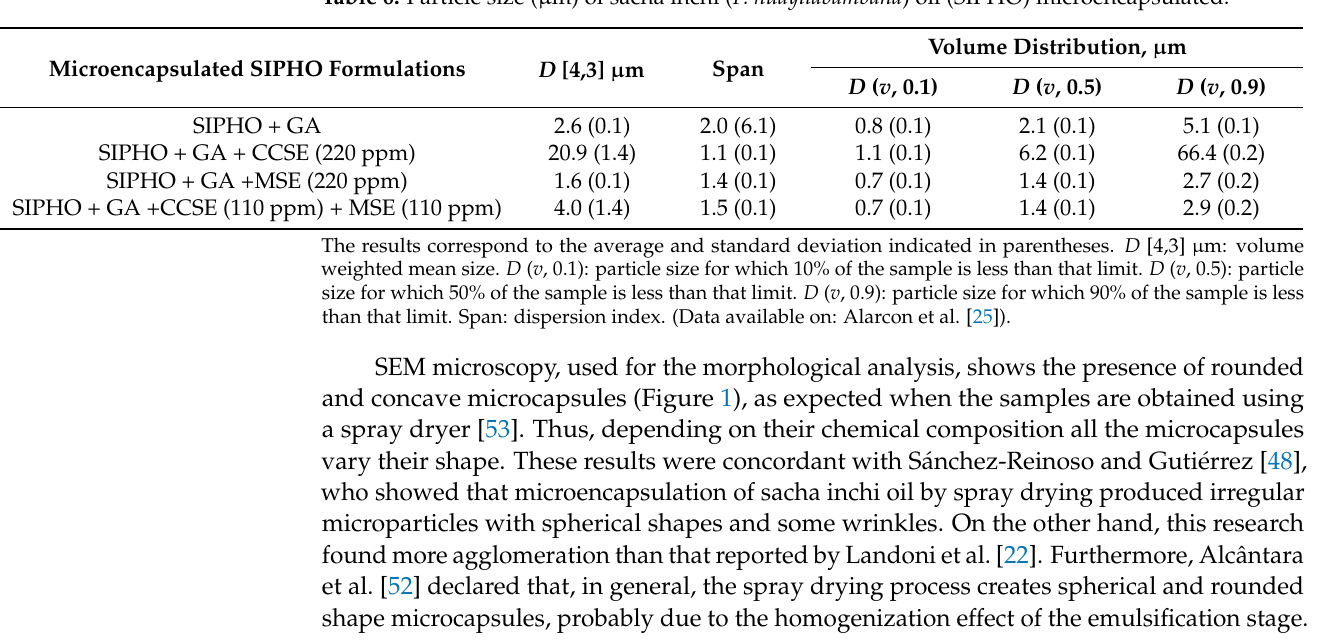
Table 6. Particle size ( µ m) of sacha inchi ( P. huayllabambana ) oil (SIPHO) microencapsulated.